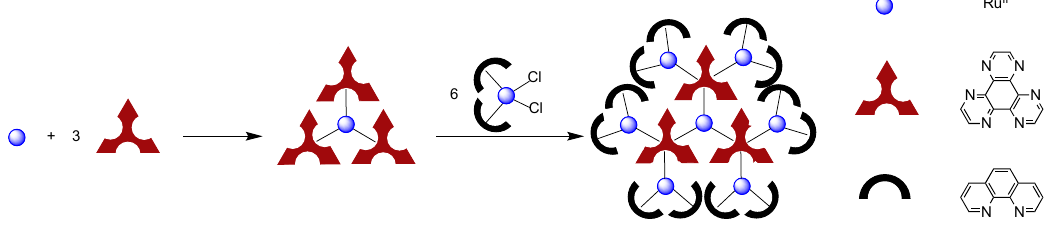
Figure 41. Pathway for the synthesis of the heptanuclear Ru II core dendrimer [168].